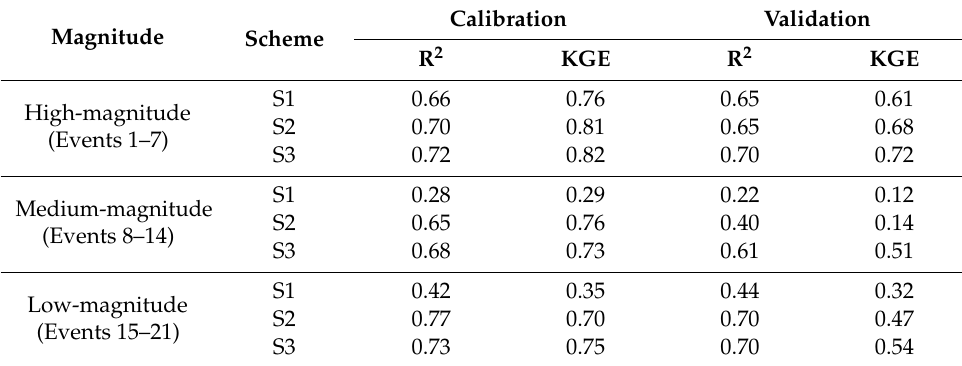
Table 6. Comparison of average R 2 and KGE for di ff erent magnitude levels of flood events with three di ff erent calibration